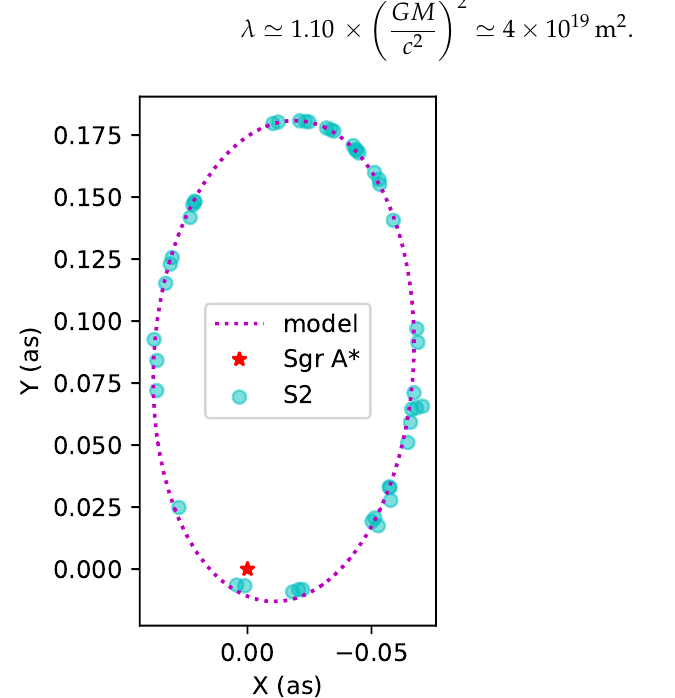
Figure 6. The figure shows the orbit fit of the S2 star using the 4D SCBH geometry using the best fit parameters R H ∼ 1.74 [ M ] and λ ∼ 1.10 [ M 2 ] . The Sgr A (cid:63) black hole is assumed to have a mass M = 4.07 × 10 6 M (cid:12) .